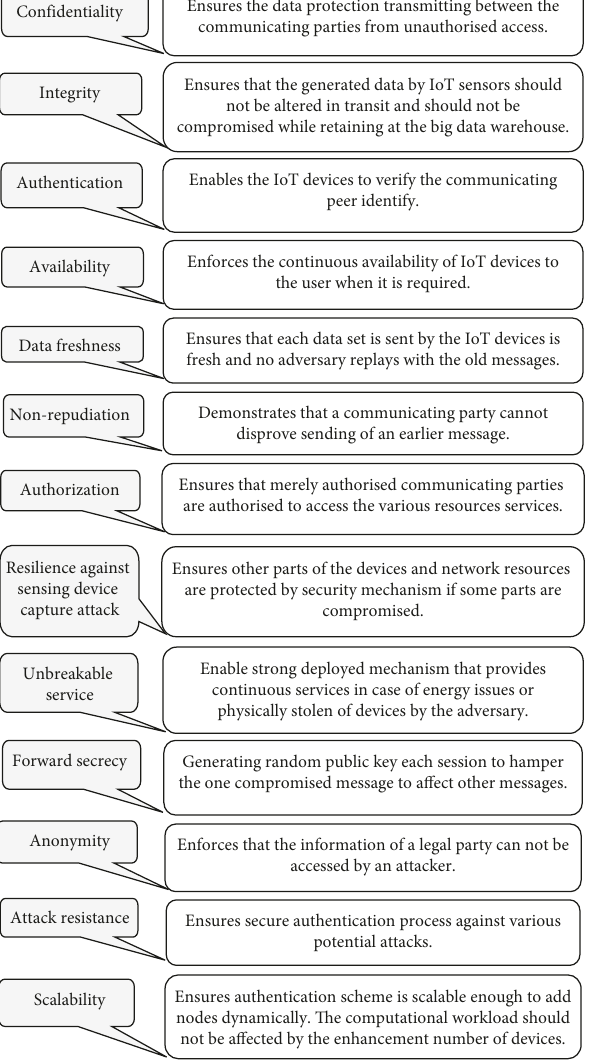
Figure 1: Security requirements in IoT perimeter